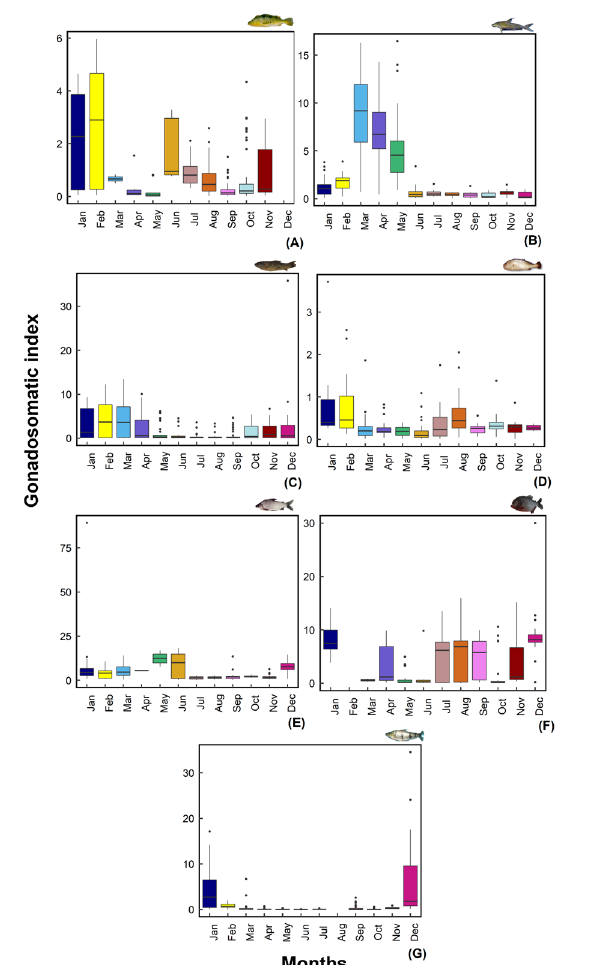
FIGURE 4 | Gonadosomatic index indicating the spawning season for ( A ) Cichla monoculus ; ( B ) Hassar affinis ; ( C ) Hoplias malabaricus ; ( D ) Plagioscion squamosissimus ; ( E ) Prochilodus lacustris ; ( F ) Pygocentrus nattereri ; and ( G ) Schizodon dissimilis , caught in Baixada Maranhense Protection Area, between January 2012 and December